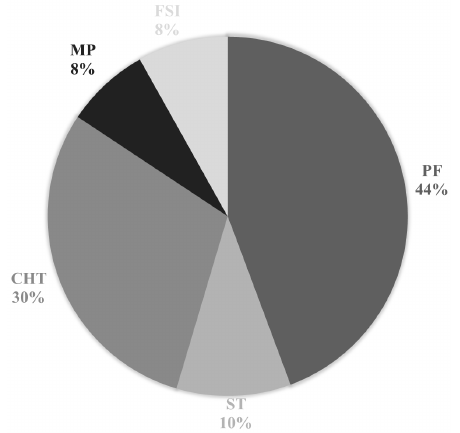
Figure 7. Distribution of papers in overall problem type: PF = pure fluid; ST = species transport; CHT = conjugate heat transfer; FSI = fluid–structure interaction; MP = microstructure and porous